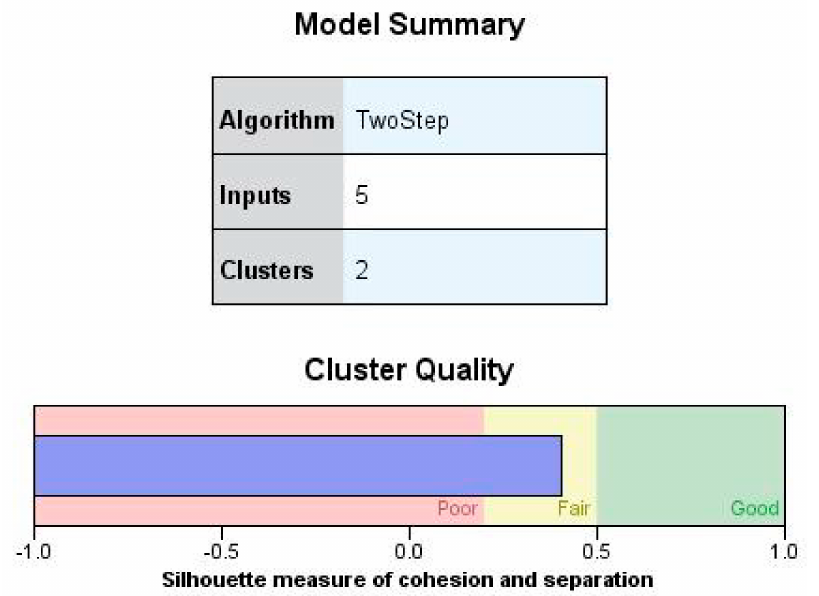
Figure 8. The TwoStep clustering model details the main five pyrolysis components showing the number and quality of clusters.